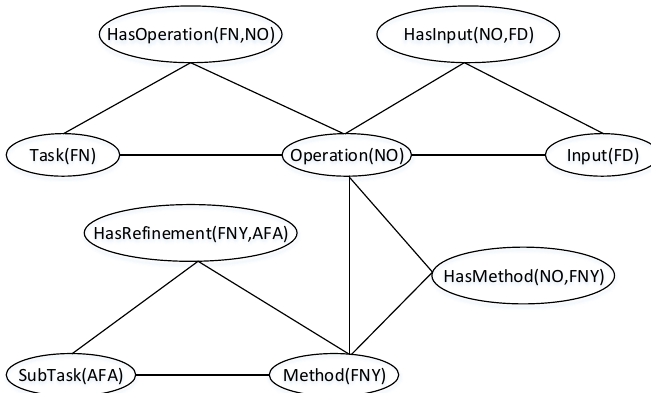
Figure 6. Ground Markov network (MN) obtained by applying MTN for the decomposition of task fireNotification Task(FN) into subtask activateFireAlarm SubTask(AFA)